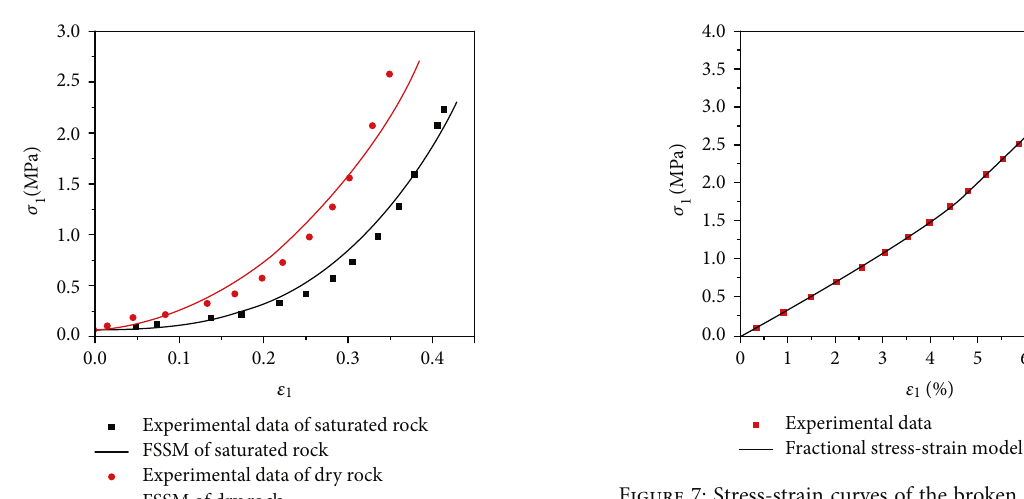
Figure 7: Stress-strain curves of the broken rock in the